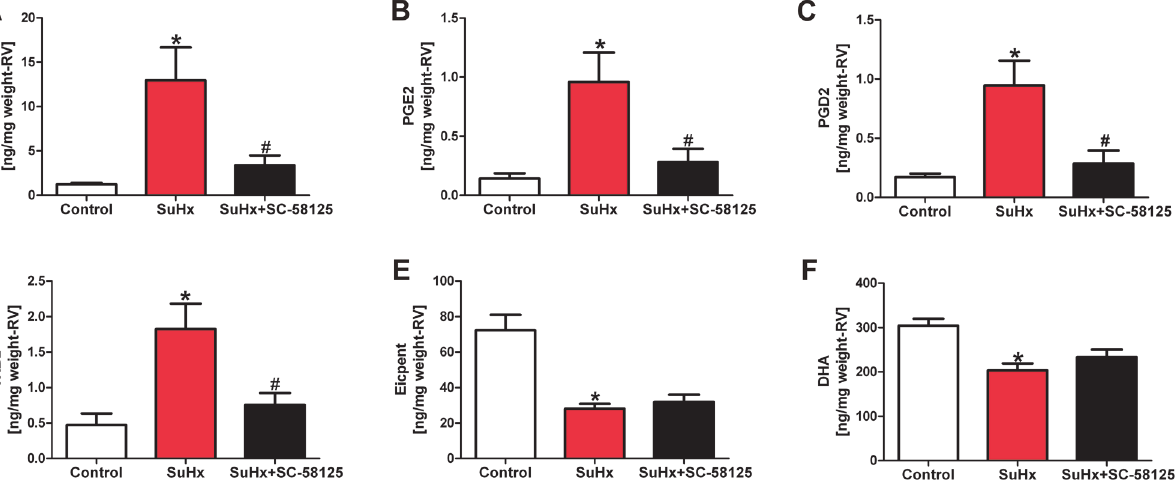
Fig 3. Eicosanoid concentrations in right ventricular tissue samples (expressed as ng/mg right ventricle tissue weight). 6-keto-PGF1 α , PGE2, PGD2 and TXB2 levels were elevated in the right ventricle tissues from SuHx rats (A, B, C and D) and this increase was prevented in animals treated with the COX-2 inhibitor. Eicosapentanoic acid (Eicpent) and docosahexanoic acid (DHA) levels were reduced in the RV tissues from the SuHx animals (E, F); treatment with SC-58125 did not affect the levels of eicosapentanoic or docosahexanoic acid levels. * P < 0.05 vs. control, #P < 0.05 vs. SuHx. (n = 4).